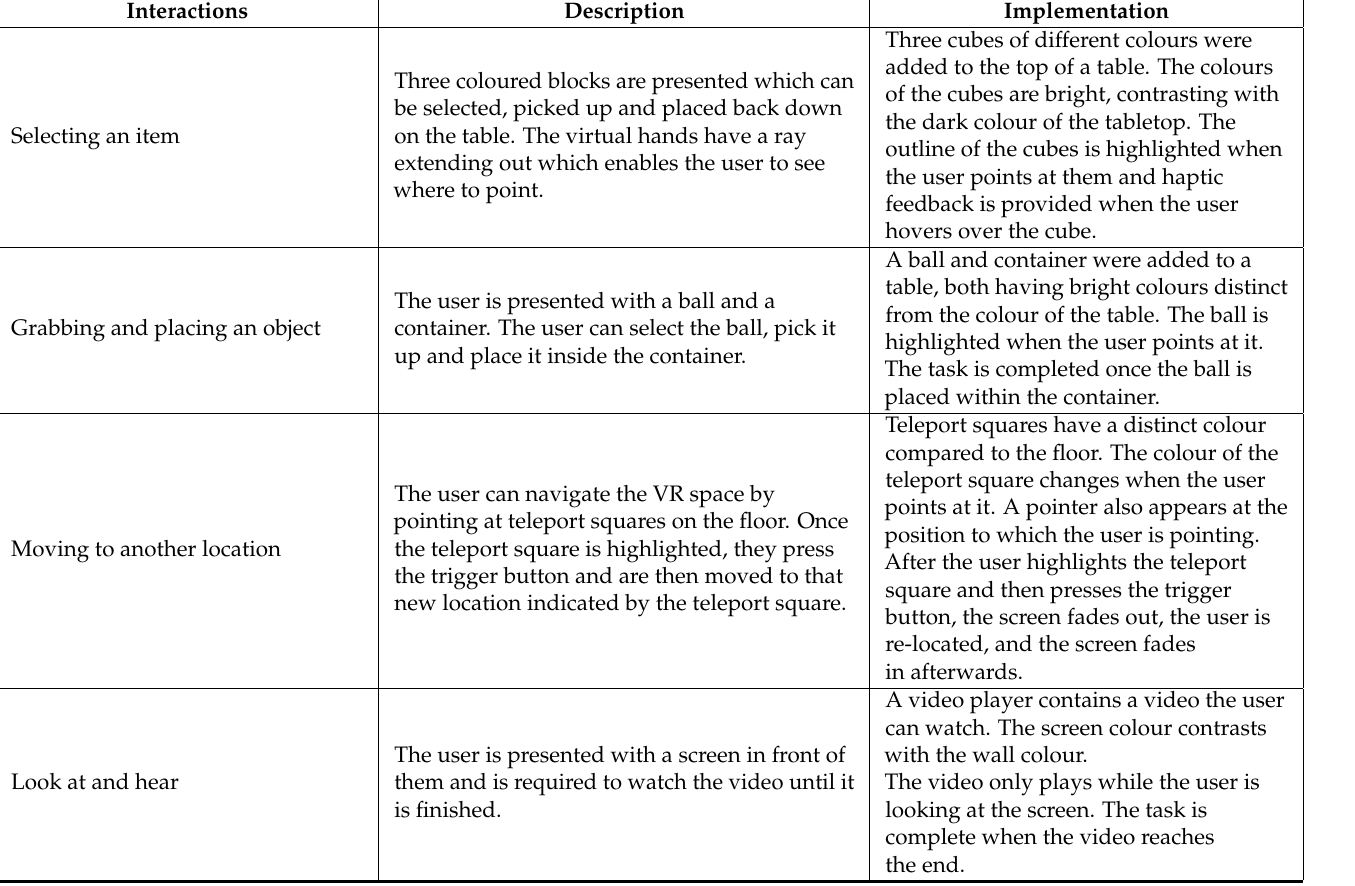
Table 1. VR FOUNDations